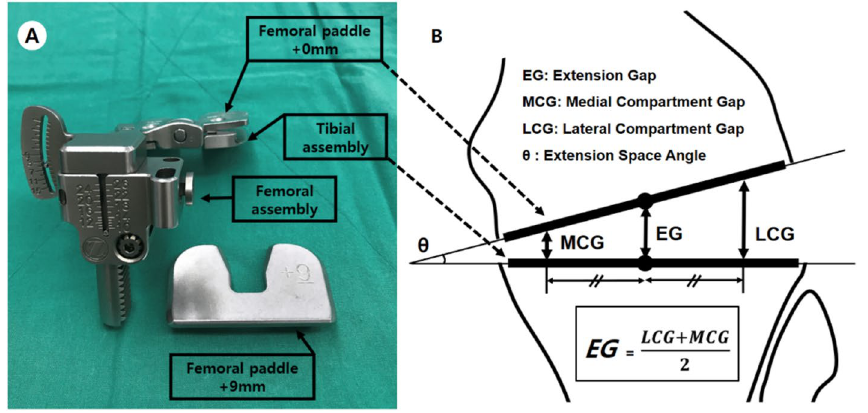
Figure 3. (A) Offset type tensor. (B) EG was defined as the distance between each center of tibial assembly and femoral paddle with distraction by the torque driver; and it was equal to the average value of LCG and